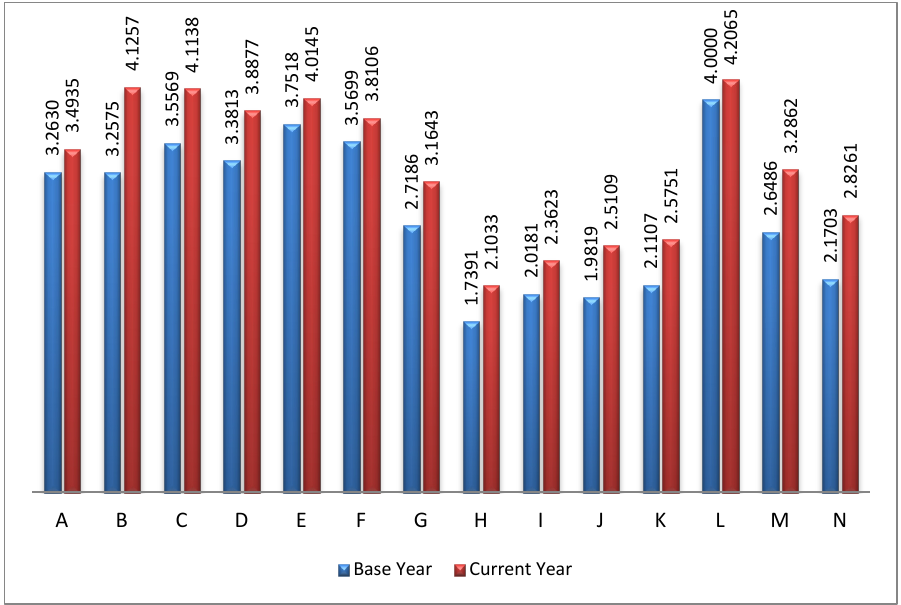
FIGURE 1: Comparison between the mean scores per category Source: Authors’ analysis